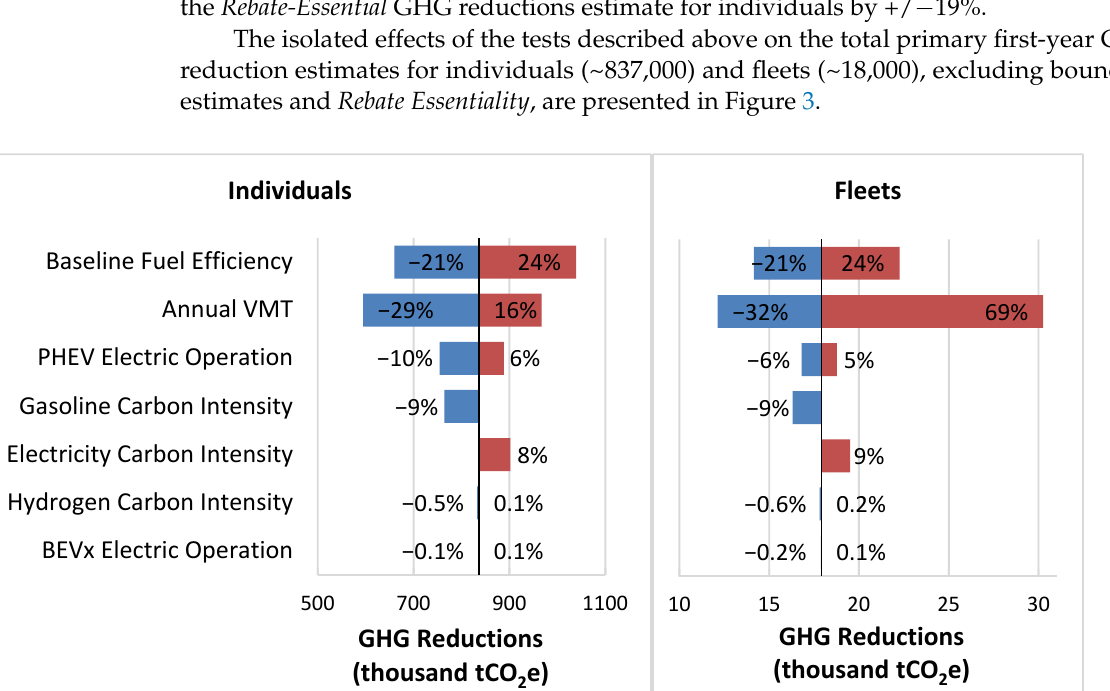
Figure 3. Per-Vehicle GHG Reduction Estimates by Rebate Type and Quantification Period.